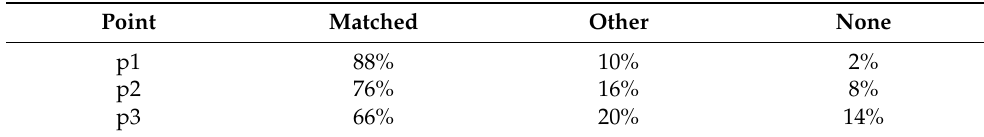
Table 4. Virtual area recognition